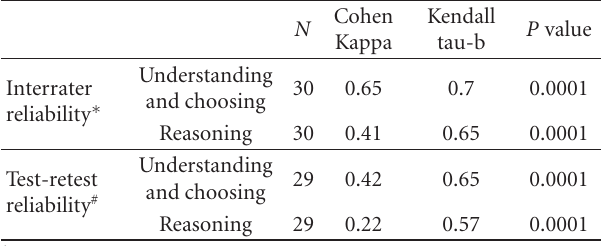
Table 4: Competence Assessment Tool for Voting (CAT-V) scoring criteria, interrater, and test-retest reliabilities.